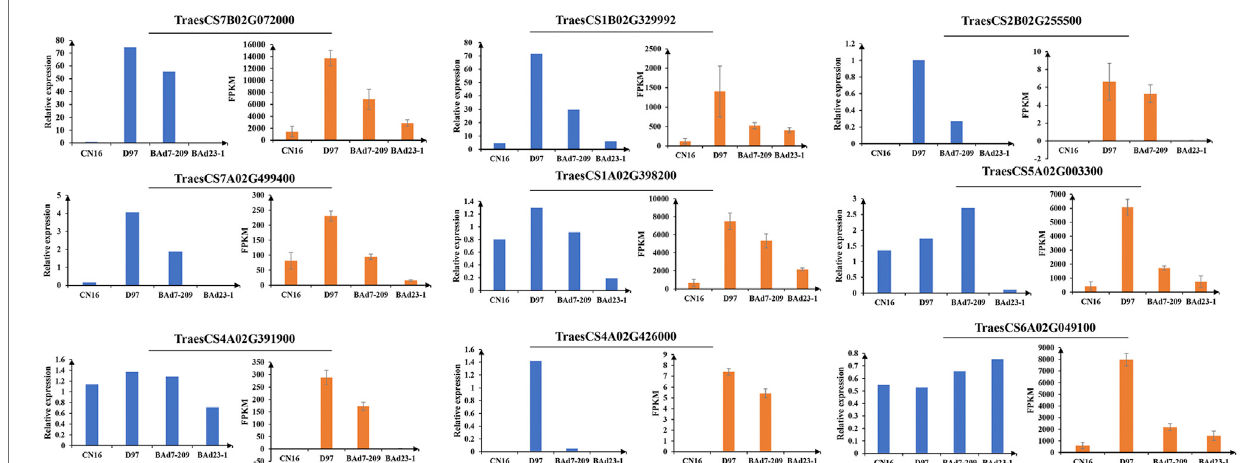
FIGURE 4 | Validation of DEGs by qRT-PCR.